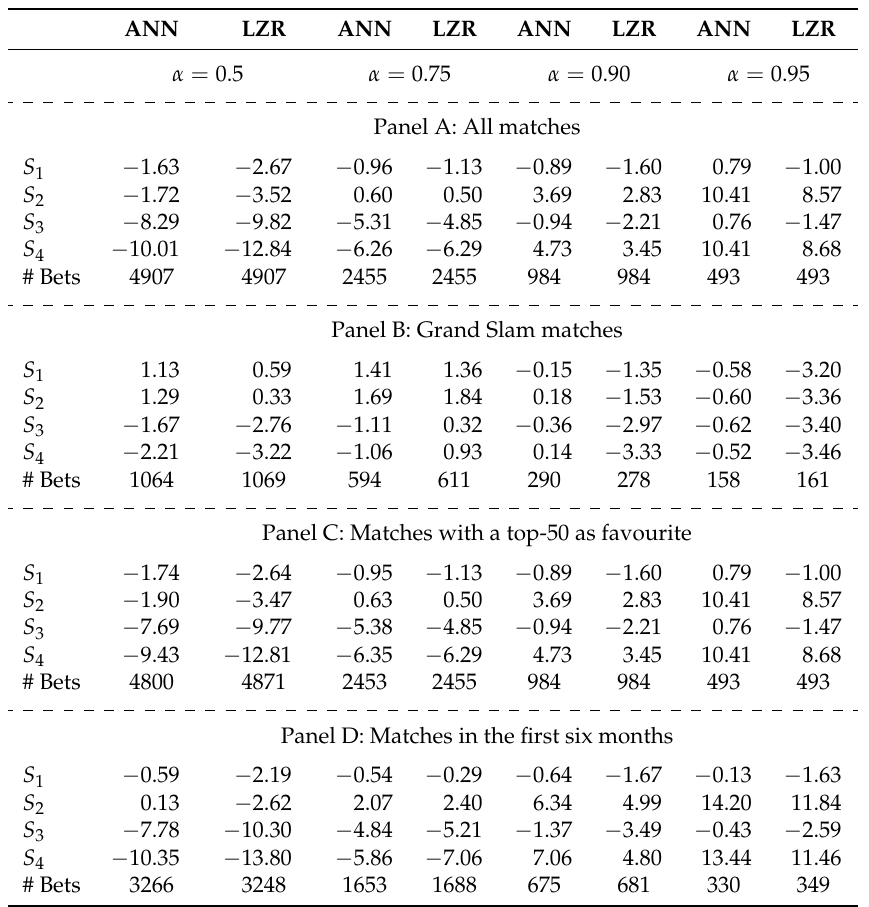
Table 3. ANN and LZR ROI (in %) for betting on